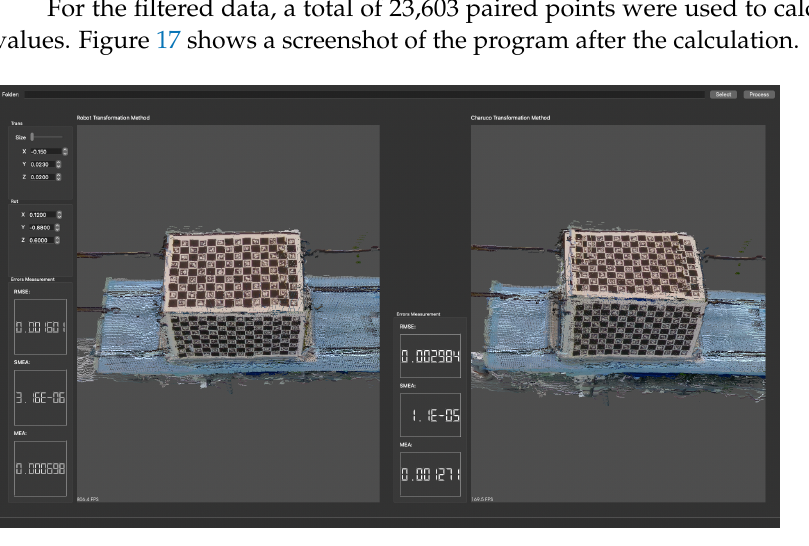
Figure 17. GUI showing the final result of the error measurement of the 3D reconstruction using filtered